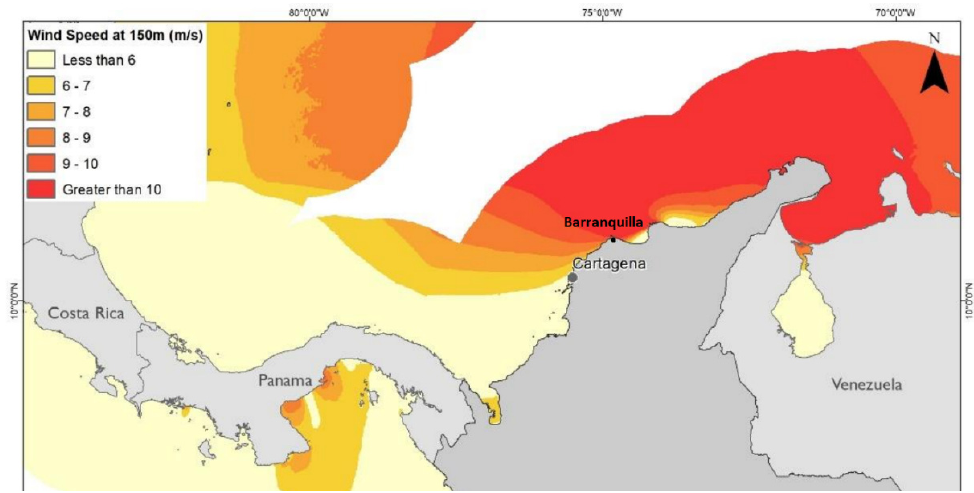
Figure 11. Wind resources in the northern part of Colombia [52].